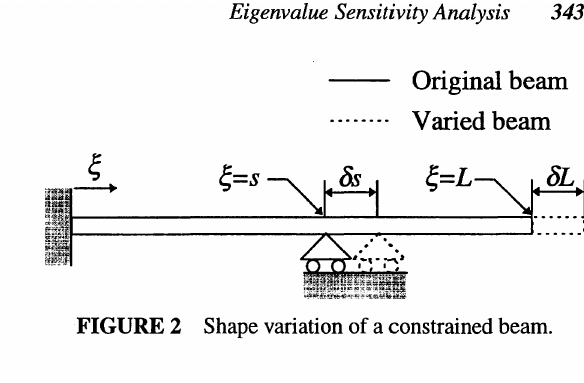
FIGURE 2 Shape variation of a constrained beam.